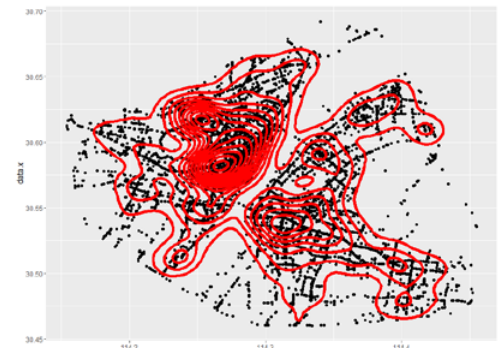
Figure 4. The equipotential line of trajectory data filed From the distribution of equipotential line, within the neighbourhood of data filed, the smaller difference of potential value between two points, the bigger probability of belonging to the same class. It is a kind of thought of using the nesting structure of the equipotential line to realize the data